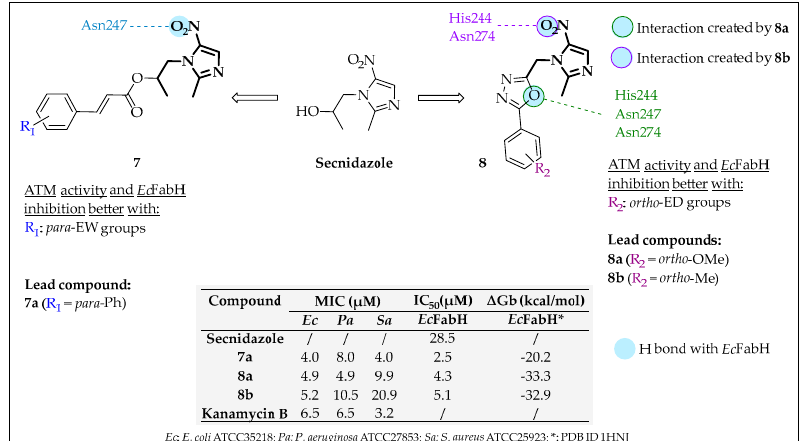
Figure 9. Structures, SAR and representation of main interactions with Ec FabH of secnidazole derivatives 7 and 8 and in vitro activities and ∆ Gb of lead compounds [79,80].